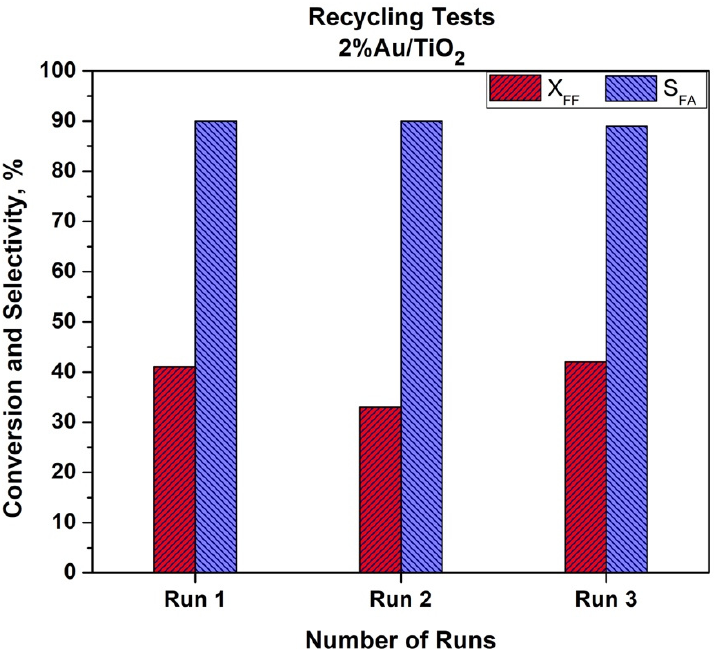
Figure 8. Recyclability tests using Au/TiO 2 catalyst (T = 110 °C, t = 2 h, P(O 2 ) = 15 bar, 600 rpm).